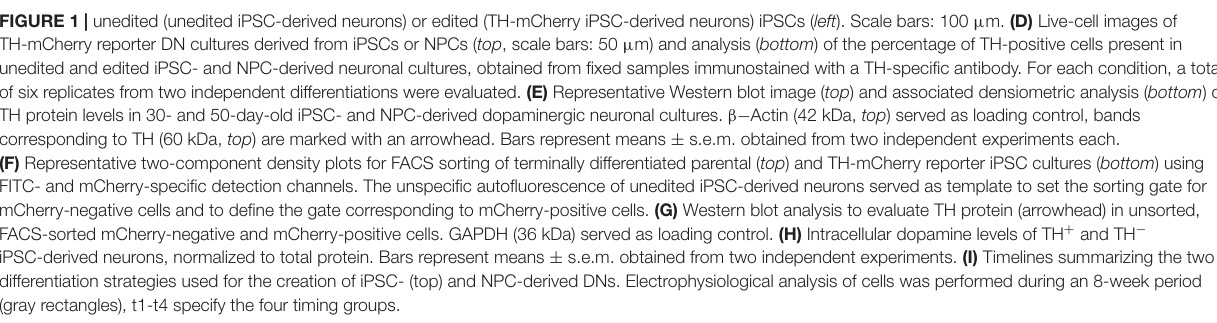
FIGURE 1 | unedited (unedited iPSC-derived neurons) or edited (TH-mCherry iPSC-derived neurons) iPSCs ( left ). Scale bars: 100 µ m. (D) Live-cell images of TH-mCherry reporter DN cultures derived from iPSCs or NPCs ( top , scale bars: 50 µ m) and analysis ( bottom ) of the percentage of TH-positive cells present in unedited and edited iPSC- and NPC-derived neuronal cultures, obtained from fixed samples immunostained with a TH-specific antibody. For each condition, a total of six replicates from two independent differentiations were evaluated. (E) Representative Western blot image ( top ) and associated densiometric analysis ( bottom ) of TH protein levels in 30- and 50-day-old iPSC- and NPC-derived dopaminergic neuronal cultures. β − Actin (42 kDa, top ) served as loading control, bands corresponding to TH (60 kDa, top ) are marked with an arrowhead. Bars represent means ± s.e.m. obtained from two independent experiments each. (F) Representative two-component density plots for FACS sorting of terminally differentiated parental ( top ) and TH-mCherry reporter iPSC cultures ( bottom ) using FITC- and mCherry-specific detection channels. The unspecific autofluorescence of unedited iPSC-derived neurons served as template to set the sorting gate for mCherry-negative cells and to define the gate corresponding to mCherry-positive cells. (G) Western blot analysis to evaluate TH protein (arrowhead) in unsorted, FACS-sorted mCherry-negative and mCherry-positive cells. GAPDH (36 kDa) served as loading control. (H) Intracellular dopamine levels of TH + and TH − iPSC-derived neurons, normalized to total protein. Bars represent means ± s.e.m. obtained from two independent experiments. (I) Timelines summarizing the two differentiation strategies used for the creation of iPSC- (top) and NPC-derived DNs. Electrophysiological analysis of cells was performed during an 8-week period (gray rectangles), t1-t4 specify the four timing